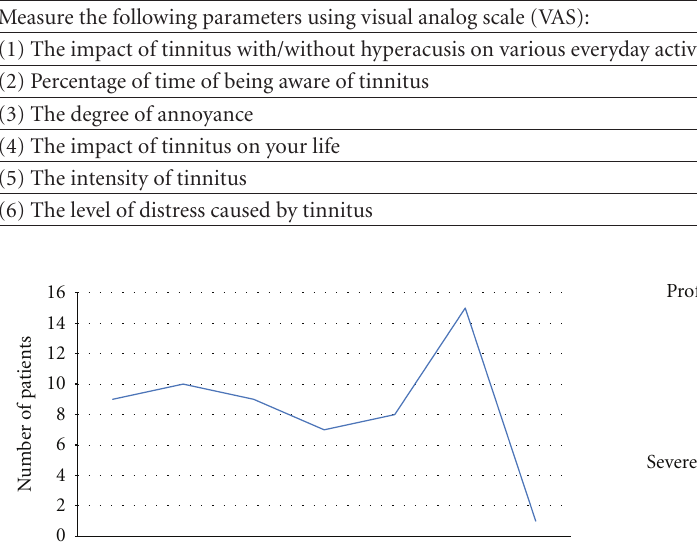
Figure 3: Number of children with tinnitus and di ff erent degrees of severity of sensorineural hearing loss (SNHL).